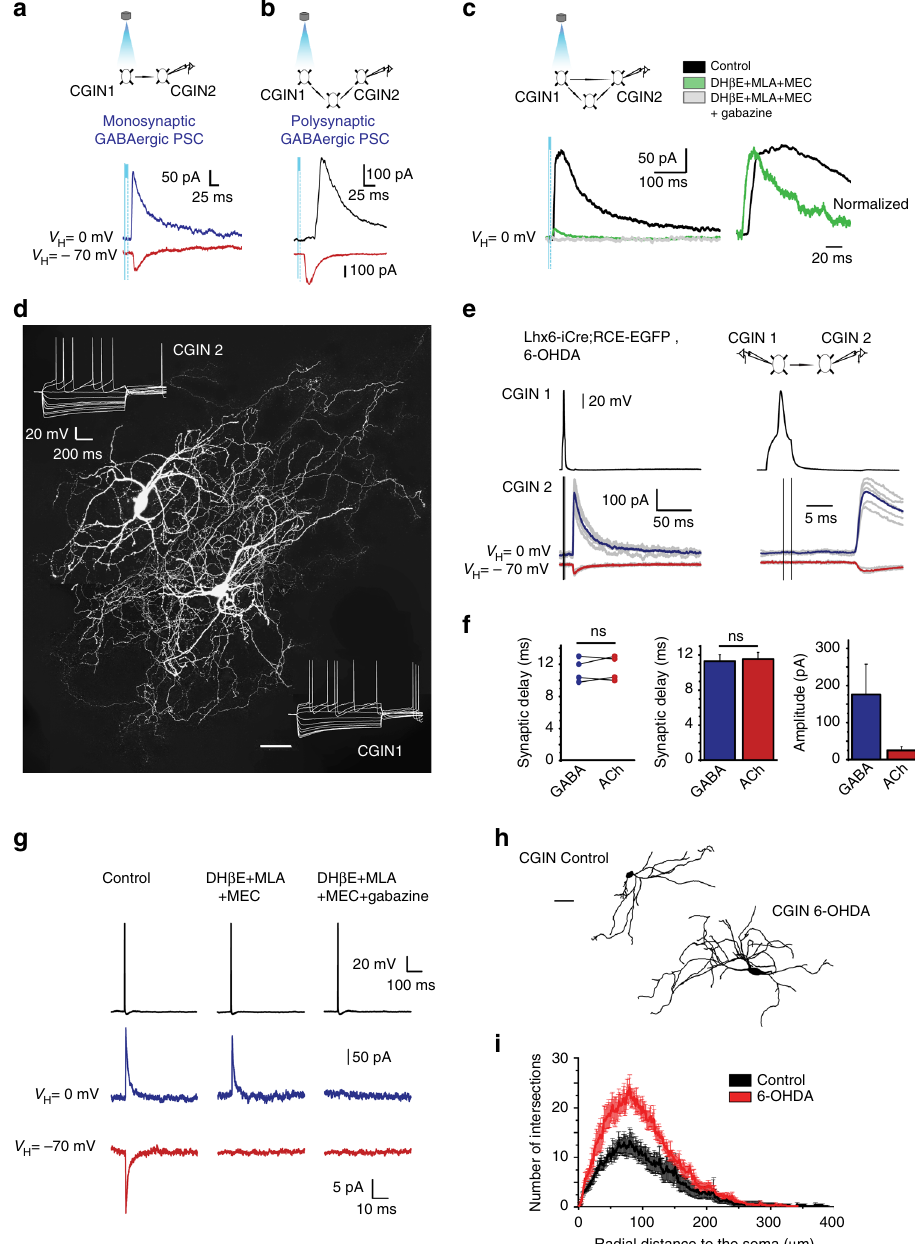
Fig. 3 CGINs co-release ACh and GABA in control and 6-OHDA-treated mice. a Monosynaptic, b polysynaptic, or c mixed GABAergic PSCs evoked in postsynaptic whole cell recorded CGIN2 in response to optogenetic stimulation of presynaptic CGIN1 (control mice). c Left: Nicotinic receptor antagonists (MEC (10 µ M), MLA (0.1 µ M), and DH β E (10 µ M)) blocked the polysynaptic but not the monosynaptic GABAergic PSC. Adding gabazine (5 µ M) blocked the monosynaptic component. Right: Superimposed and normalized polysynaptic and monosynaptic GABAergic PSCs at extended scale. d Representative image of two identi fi ed biocytin- fi lled, monosynaptically-connected CGINs. e Left: Outward (GABAergic) and inward (cholinergic) PSCs evoked in postsynaptic CGIN2 (bottom) in response to a presynaptic spike generated in CGIN1 (top); right: same traces at an extended time scale. f Individual and averaged synaptic delays and amplitudes of GABAergic and cholinergic PSCs. g Blockade of inward and outward PSCs by nicotinic receptor antagonists and gabazine, respectively. h Representative reconstructed CGINs dendritic trees from control and 6-OHDA-treated mice. i Sholl analysis of CGINs dendrites from control and 6-OHDA-treated mice. Scale bar: d 50 µ m and h 50 µ m. All means ± SEM. f Signi fi cance was determined by two-tailed, unpaired Student ’ s t -test; i data sets were analyzed using Kolmogorov-Smirnov test. See Supplementary Table 1 for statistics; NS, not signi fi